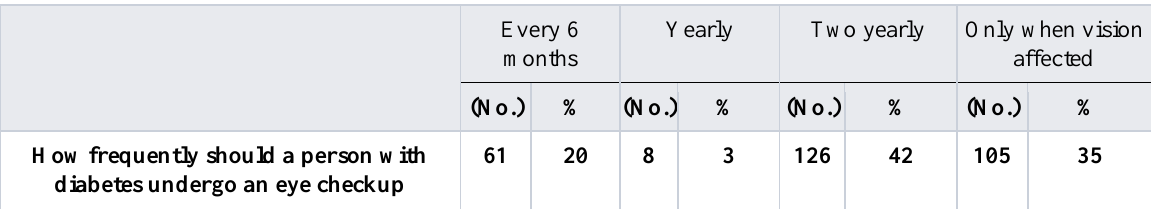
Table (2): The distributions of studied sample according to their sources of information How did you come to know about this/these complication/s